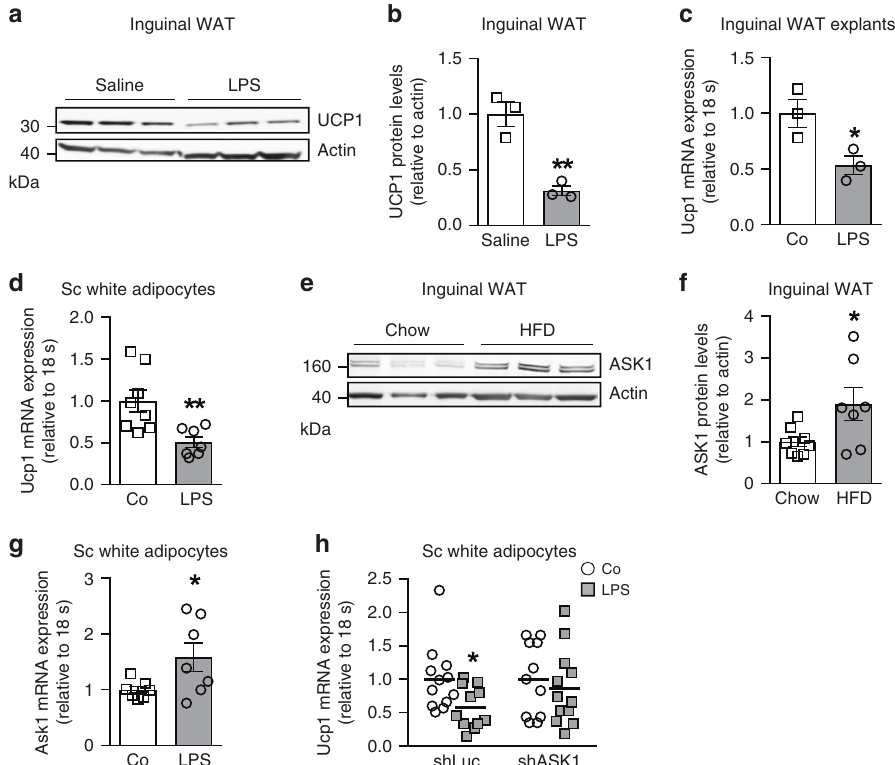
Fig. 1 LPS treatment blunts UCP1 expression in subcutaneous adipocytes ASK1-dependently. a , b Western blot and quanti fi ed protein levels of UCP1 in total lysates of inguinal white adipose tissue harvested from cold-exposed C57BL/6J mice chronically treated with or without LPS. n = 3 mice per group. ** p = 0.004. c Ucp1 mRNA expression in inguinal fat explants harvested from C57BL/6J mice were treated with or without 100 ng/ml LPS and subsequently with 10 µ M isoproterenol for 8 h. n = 3 biological replicates. * p = 0.036. d Ucp1 mRNA expression in subcutaneous adipocytes pre-treated with or without 100 ng/ml LPS for 24 h followed by stimulation with 0.1 µ M isoproterenol for 6 h. n = 7 (LPS) or n = 8 (control) biological replicates. ** p = 0.007. e , f Western blot and quanti fi ed protein levels of ASK1 in total lysates of inguinal white adipose tissue harvested from C57BL/6J mice fed a chow or HFD for 20 weeks. n = 8 (chow) and n = 7 (HFD) mice per group. * p = 0.037. g Ask1 mRNA expression in subcutaneous adipocytes treated with or without 100 ng/ml LPS treatment for 24 h. n = 7 biological replicates. * p = 0.046. h Ucp1 mRNA expression in subcutaneous adipocytes transfected with control shRNA lentivirus (shLuc) or shRNA lentivirus targeting ASK1 (shASK1) pre-treated with 100 ng/ml LPS for 24 h followed by stimulation with 0.1 µ M isoproterenol for 6 h. n = 11 (shASK1 control and shLuc LPS) or n = 12 (shASK1 LPS and shLuc control) biological replicates. * p = 0.027. Values are expressed as mean ± SEM. Statistical tests used: two-sided t -tests for ( b – d , f – h ). Source data are provided as a Source Data fi